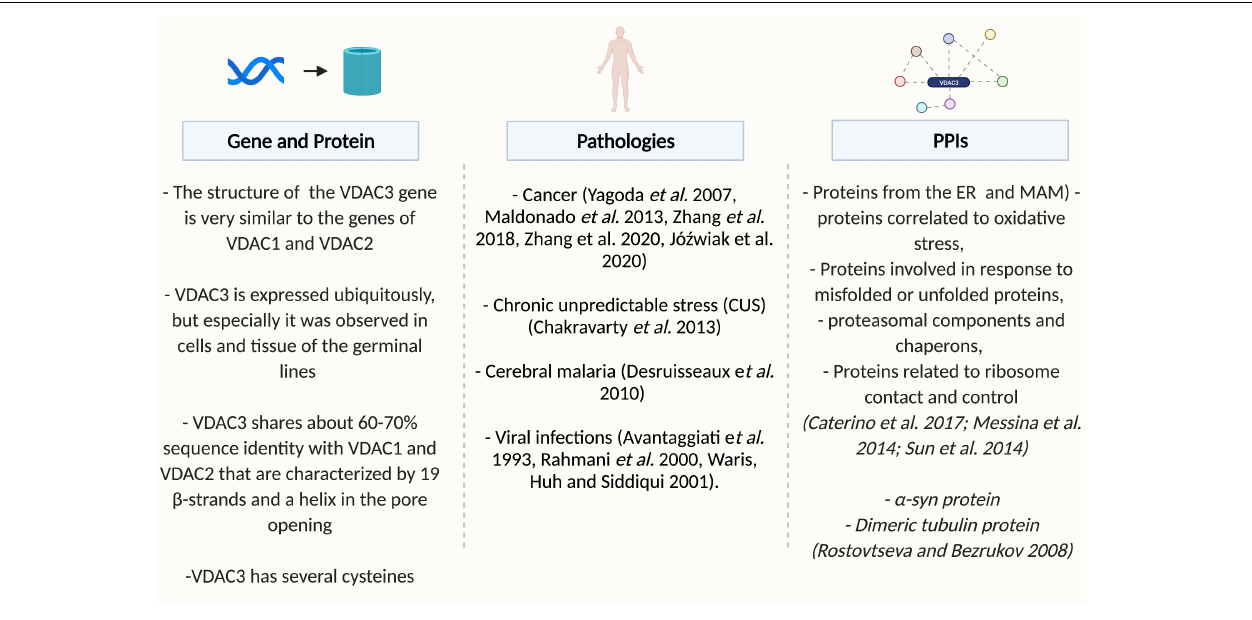
FIGURE 1 | Overview of VDAC3. Created by